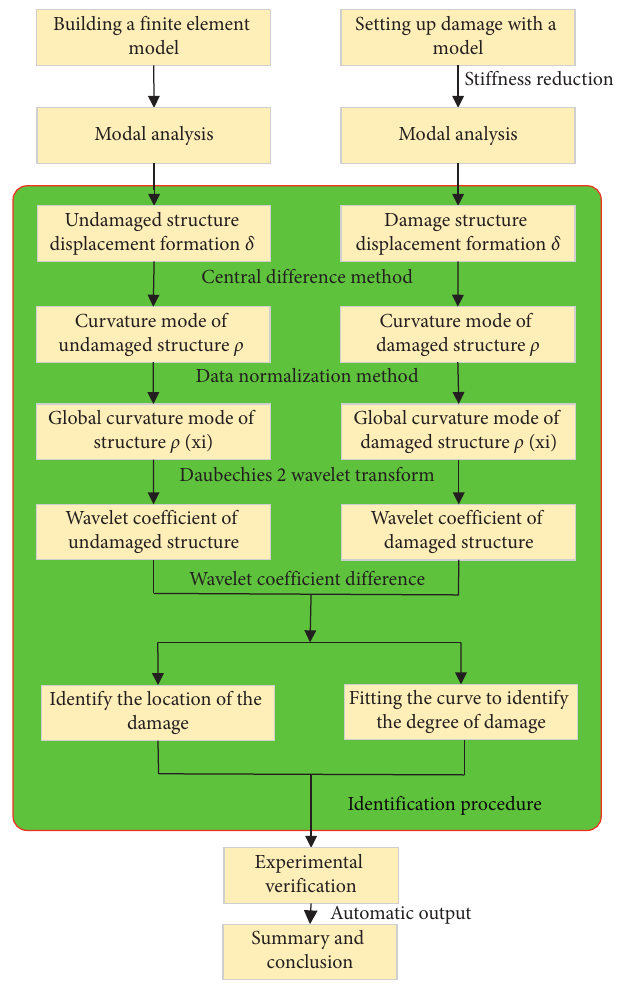
Figure 1: Flow chart of damage identification.